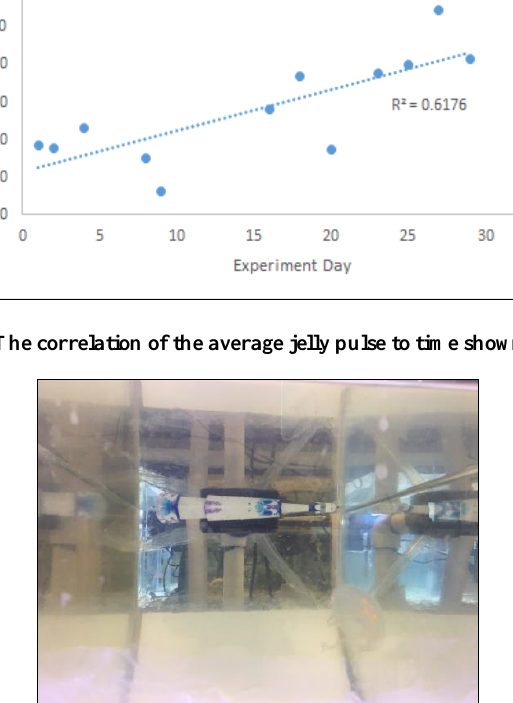
Figure 8. Shows the set up design of the spray bar that prevents the jellies being sucked into the